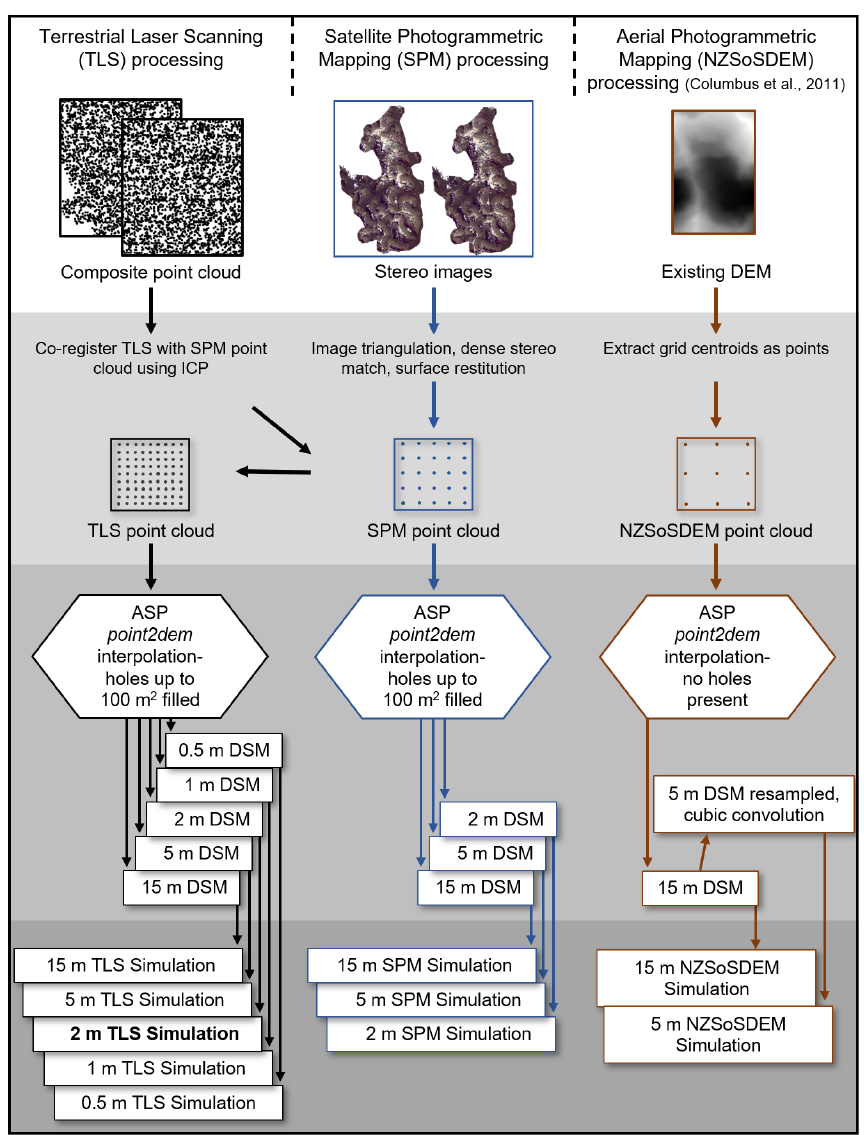
Figure 3. Data processing workflow to generate the individual RAMMS simulations used to test the sensitivity of the dynamic model to topographic representation from the three input datasets: terrestrial laser scanning point cloud, Pléiades satellite bi-stereo images and the NZSoSDEM nationwide DEM for Aotearoa/New Zealand. The 2m TLS reference simulation is noted in